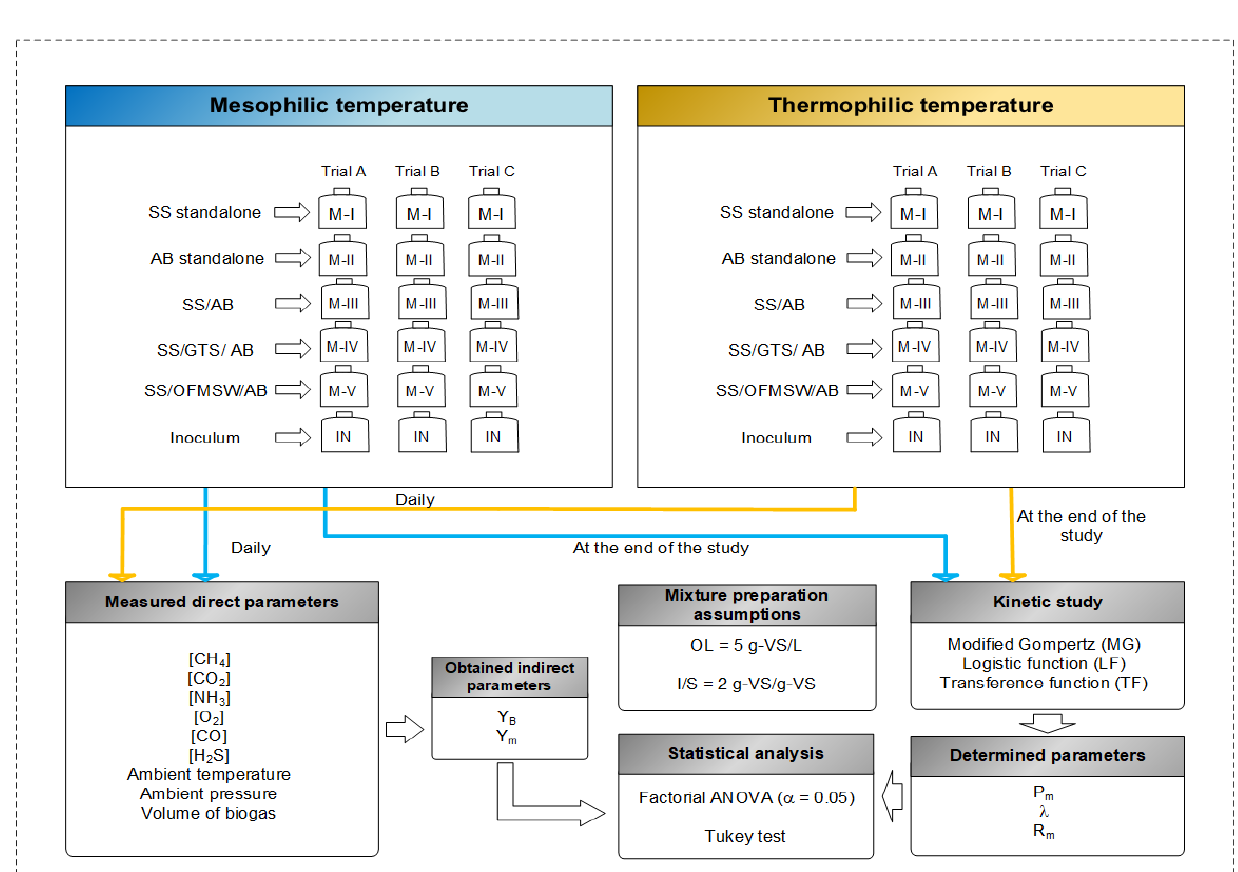
Figure 1. Scheme of the experiment related to the BMP assay.